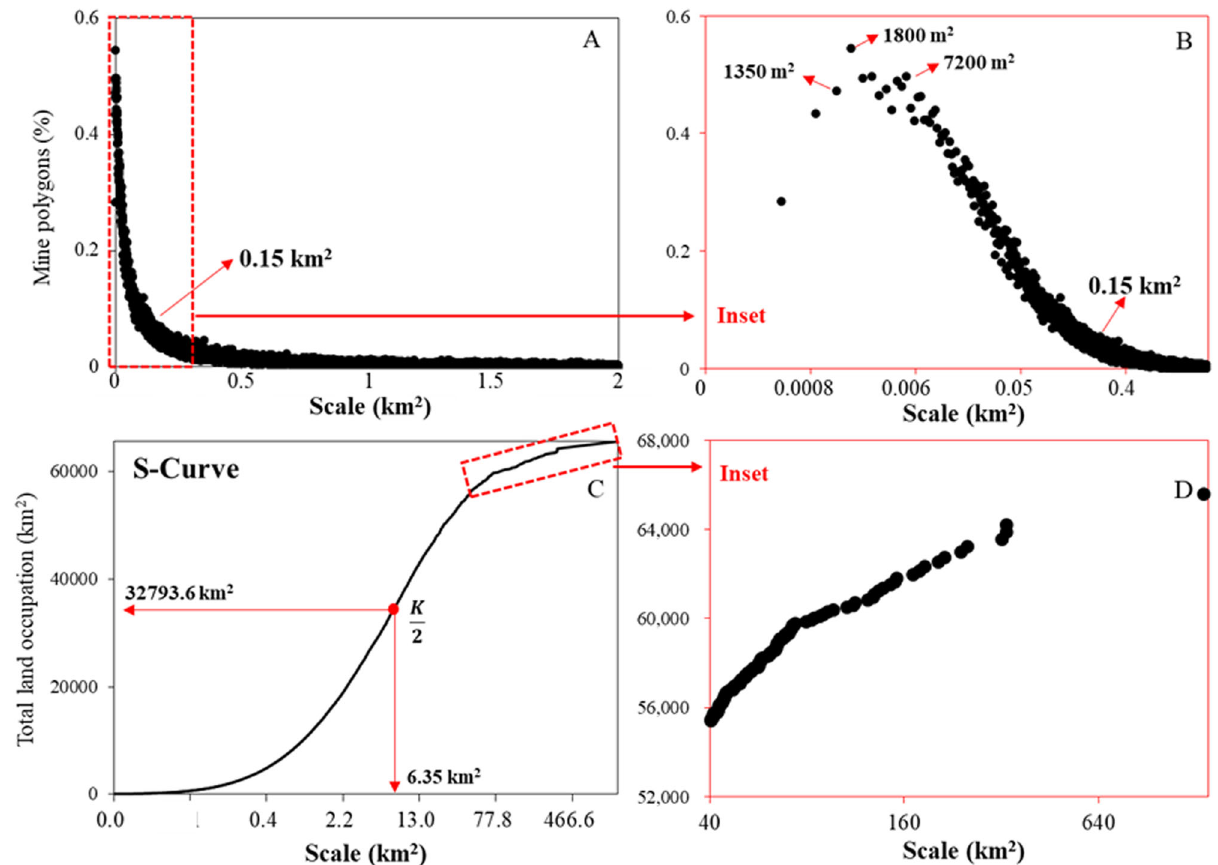
Fig. 3 Distribution of global mine area polygons by size. A Overall frequency distribution of mine area scales, noting that there may be under representation of polygons at the smallest scales due to limitations in ASM coverage; B Inset of small-scale mine areas; C S-curve of increasing total mine area versus the scale of mine polygons; D Inset of S-the curve of the largest-scale mine